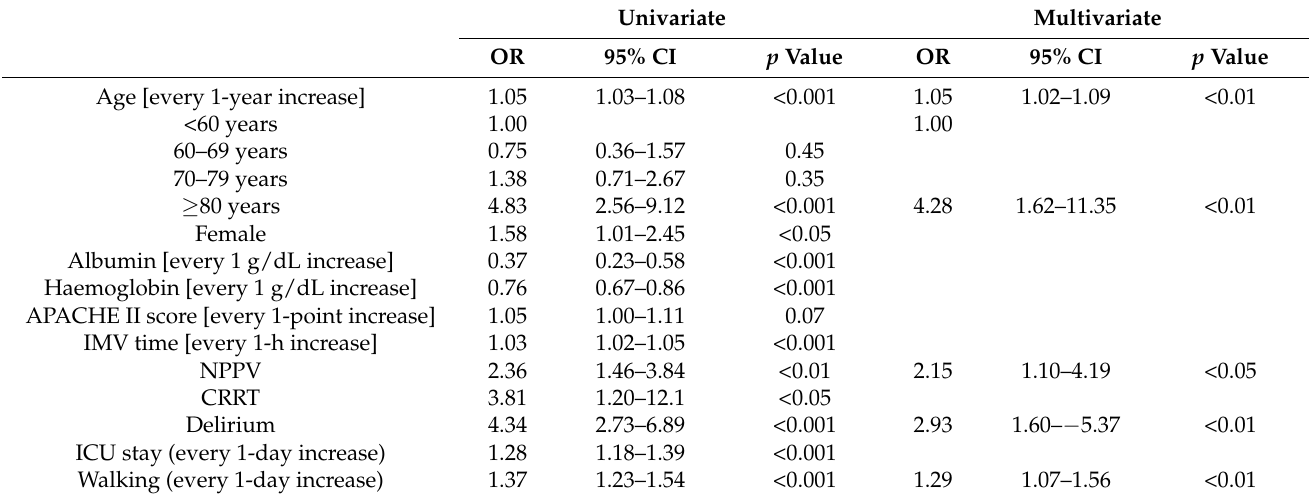
Table 4. Univariate and multivariate analyses for hospitalisation-associated disability. Univariate Multivariate